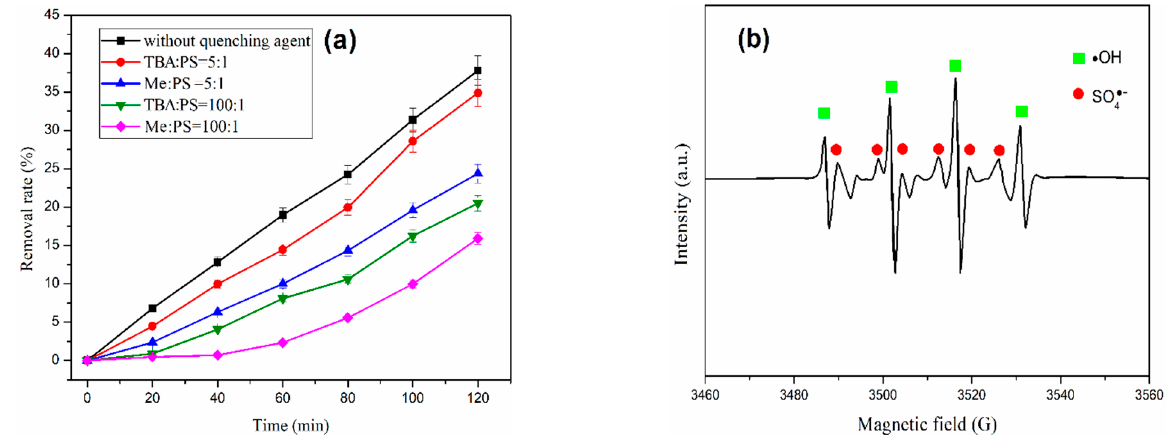
Figure 10. ( a ) Effect of free radical quenching agents on ciprofloxacin removal, and ( b ) the EPR experiment result for detecting SO4• − and •OH.